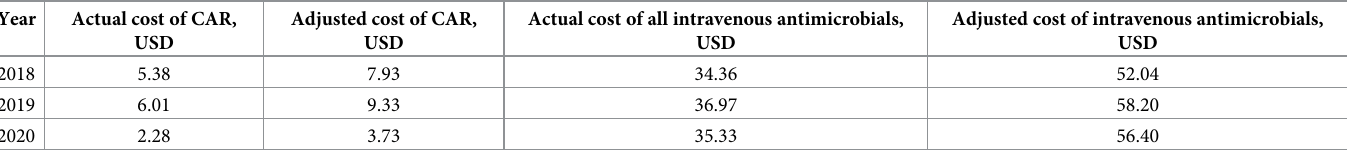
Table 2. Purchase costs of carbapenems and all intravenous antimicrobials per patient-days from 2018 to 2020.